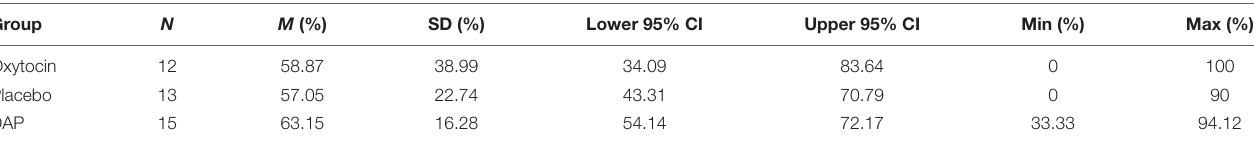
TABLE 5 | Mean percentage of correct choices made by all dogs in each treatment group.